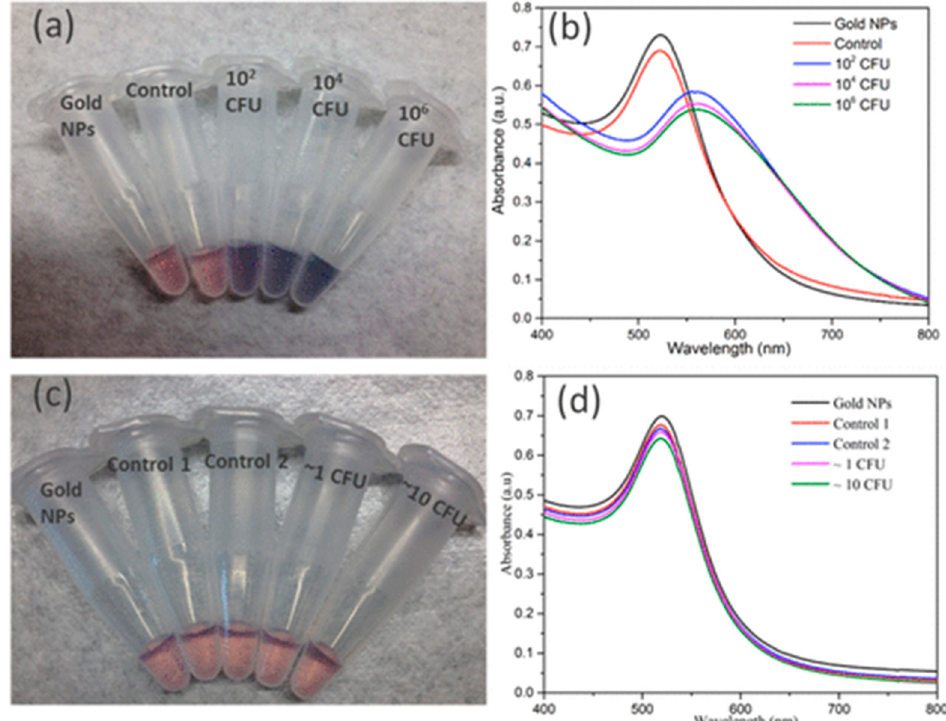
Figure 16. ( a , c ) Digital photographs showing detection of E. coli using thiolated M13KE and AuNPs. ( b , d ) UV–vis spectra. From left to right in ( a ), samples containing AuNPs and: no bacteria or phages (black line in ( b )), unmodified M13KE with 10 6 CFU E. coli (red line in ( b )), and thiolated M13KE with E. coli at different CFU’s (10 2 , 10 4 , and 10 6 ) (blue, magenta, and green lines, respectively, in ( b )). From left to right in ( c ), samples containing AuNPs and: no bacteria (black line in ( d )), unmodified M13KE phage and ∼ 10 CFU of E. coli (red and blue lines in ( d ), respectively), and thiolated M13KE phage and ∼ 10 CFU of E. coli (magenta and green lines in ( d ), respectively). Reproduced with permission from [191].